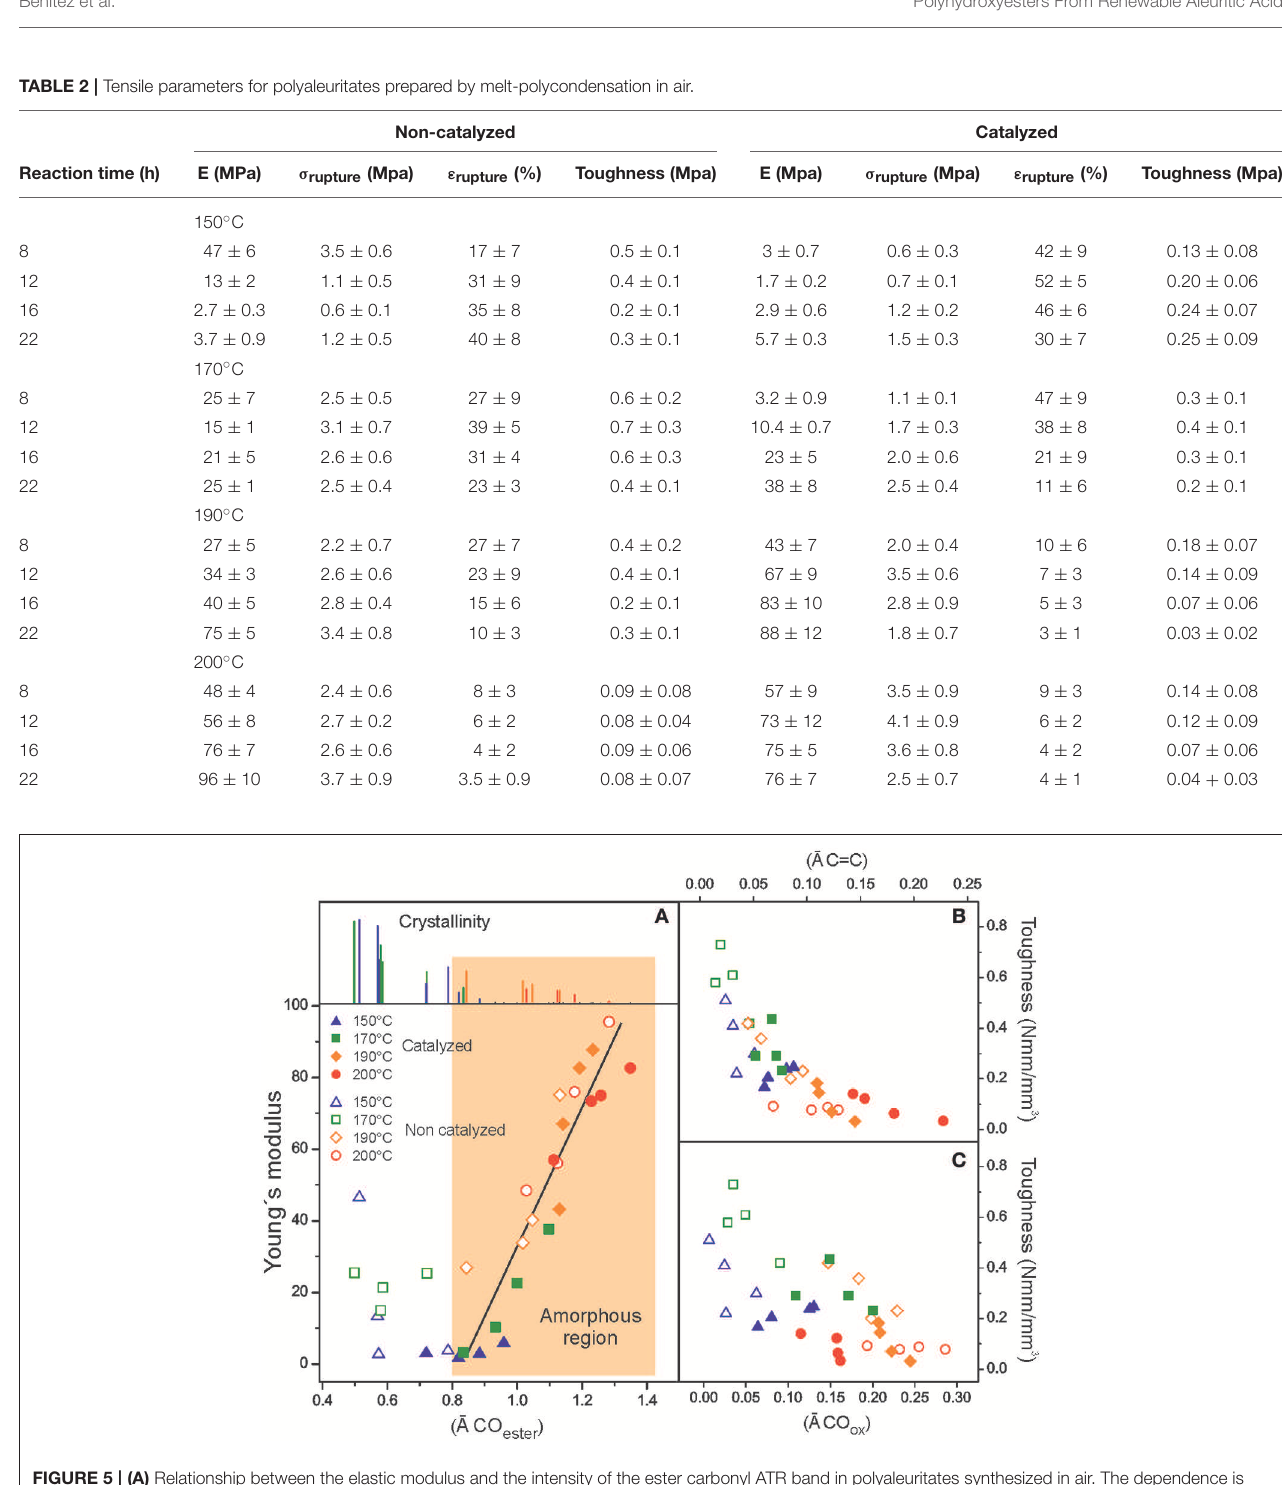
robust crosslinked frameworks are characterized by a low strain, a flat equilibrium region and a fast recovery due to the absence of flow under stress (Macosko, 1994; Menard, 2008). Creep and stress relaxation performance is affected by other